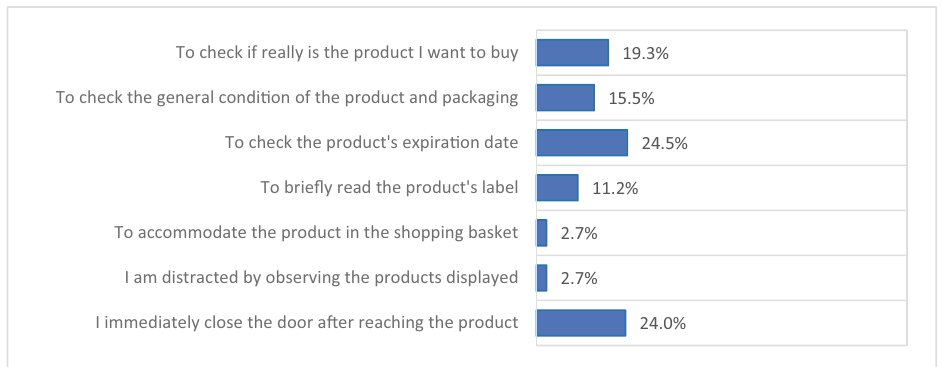
Figure 6: Results for the question: “ Indicate up to three of the possible main reasons to maintain the door open of the refrigerated display cabinet, while deciding catch up the desired product? ”